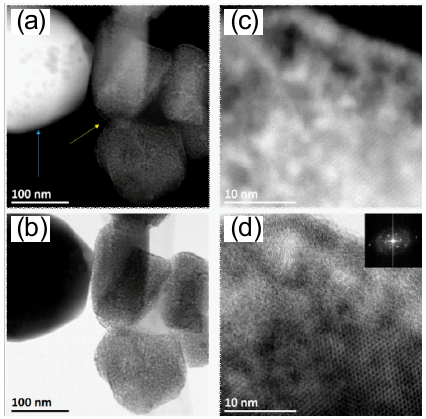
Figure 3 . STEM images of 2.75 at.% Rh-Loaded In 2 O 3 . ( a ) STEM HAADF and ( b ) STEM bright-field (BF) images show two kinds of structures: low Rh-loaded (blue arrows) and high Rh-loaded (yellow arrow). ( c ) High-resolution (HR)-STEM HAADF and ( d ) HR-STEM BF images show high crystalline In 2 O 3 and a rich Rh layer around In 2 O 3 . The inset in ( d ) is the fast Fourier transform (FFT) of the STEM BF image.